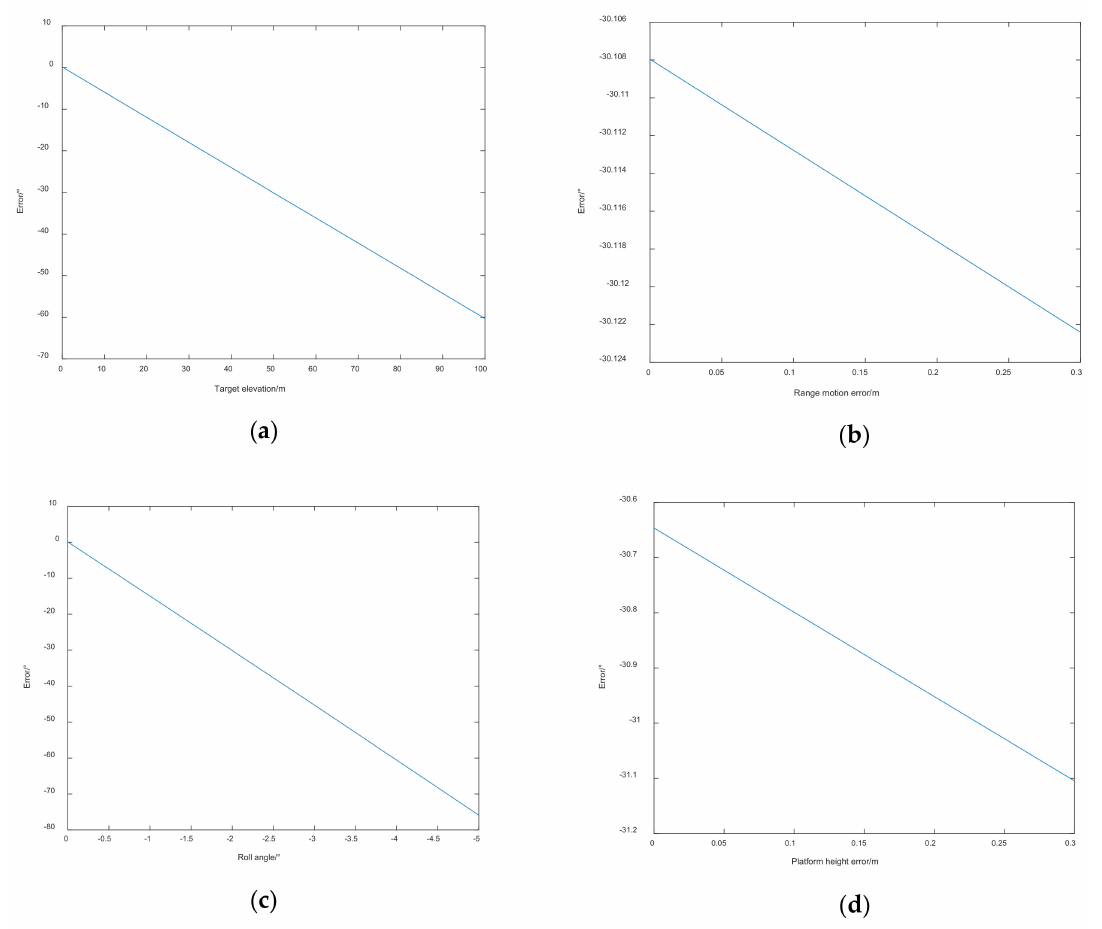
Figure 7. ( a ) Influence of target elevation. ( b ) Influence of range motion error. ( c ) Influence of roll angle. ( d ) Influence of platform height error.